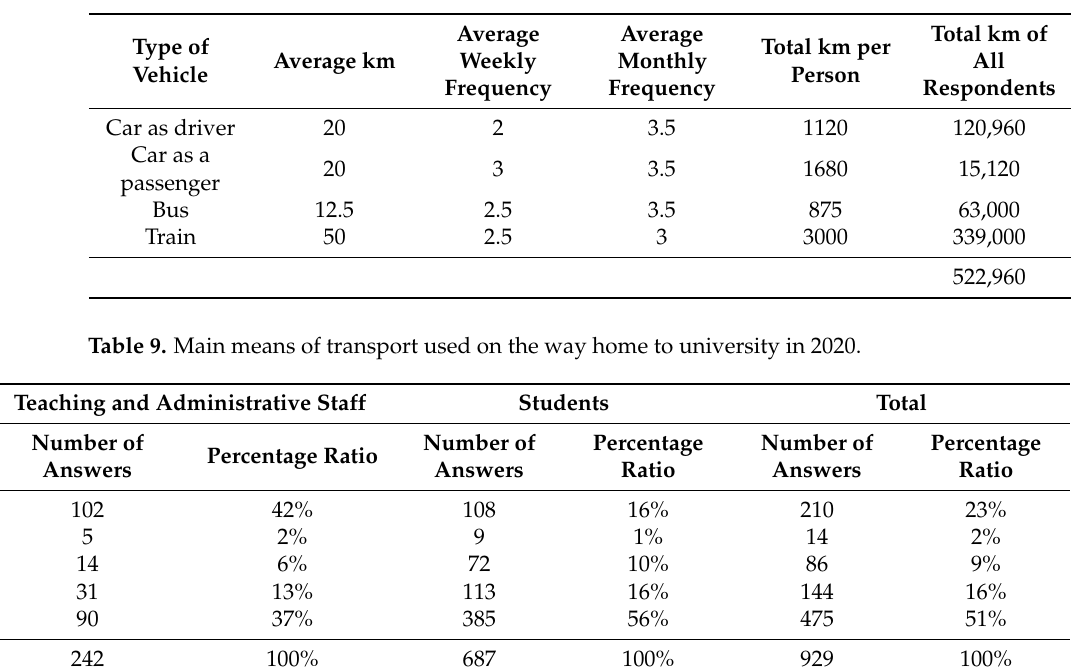
Table 8. Total km for student by mode of transport in 2020.